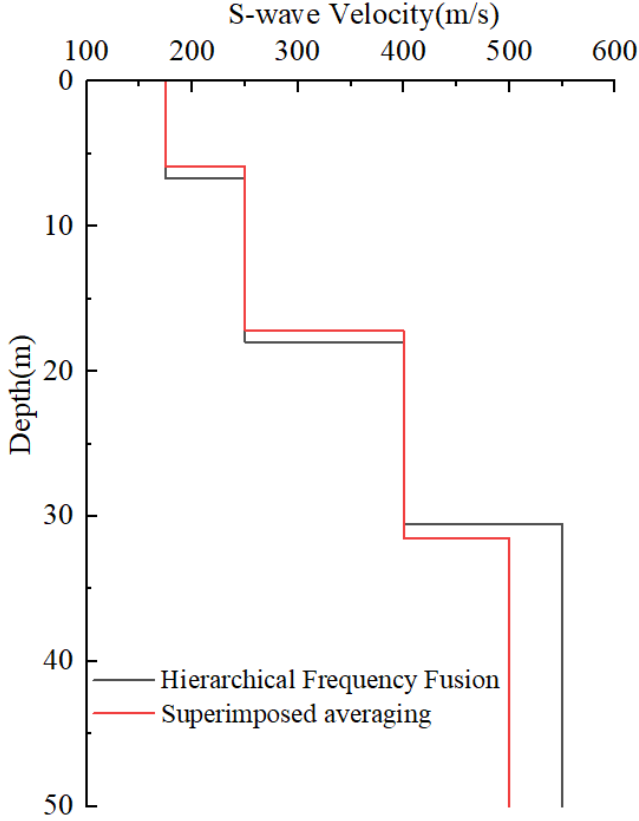
Figure 15. S-wave velocity structure of hierarchical frequency fusion and superimposed averaging.